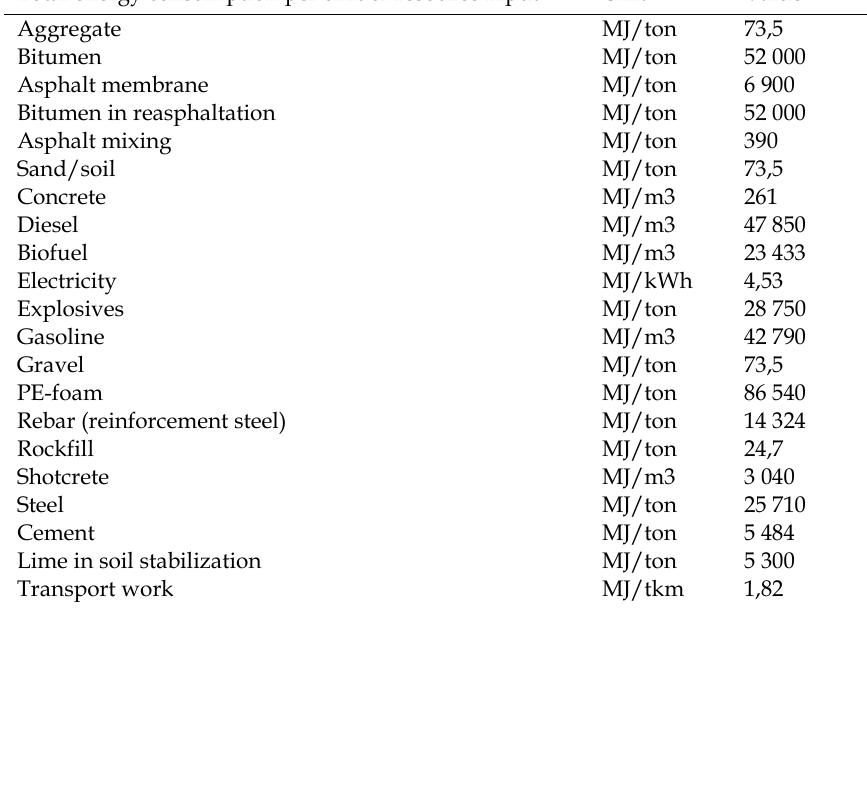
Table C. Energy consumption materials and fuels used in LICCER